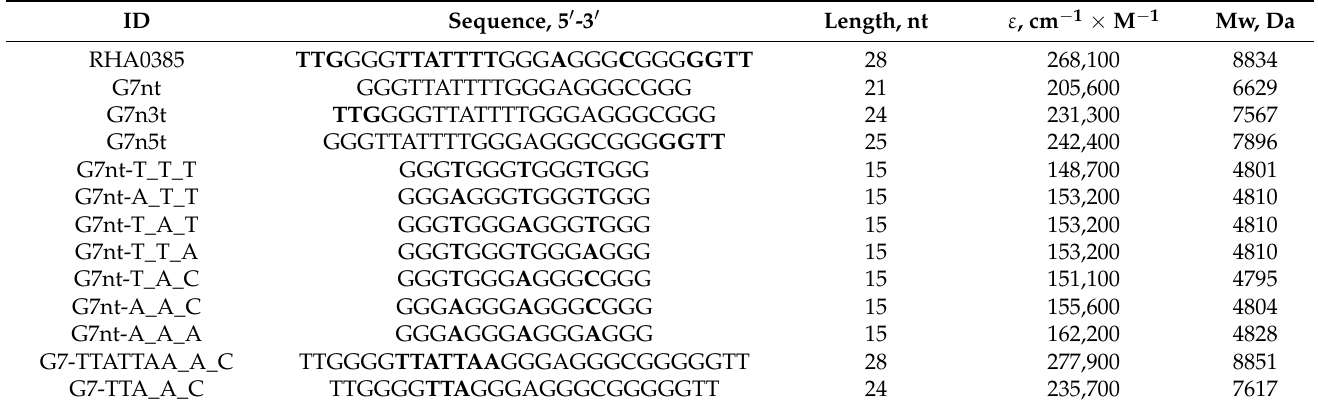
Table 1. RHA0385 variants: sequences, lengths, extinction coefficients and molecular weights. The sequences under alteration are shown in